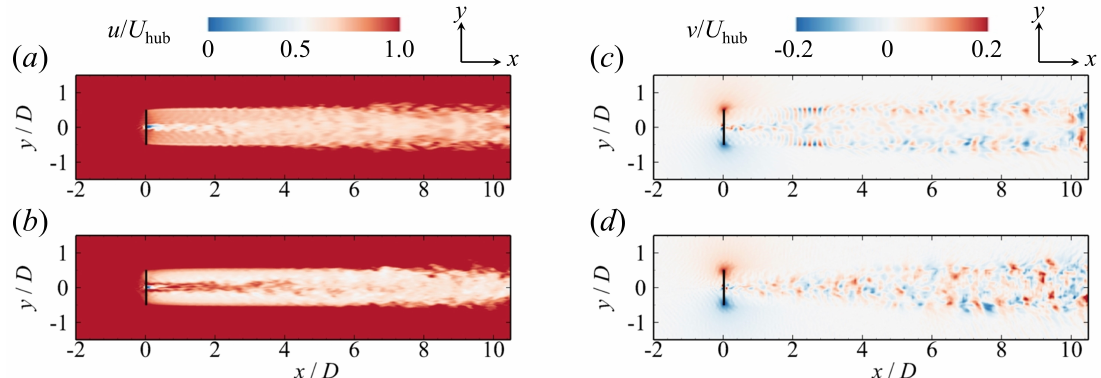
Figure 2. Uniform inflow: contours of the instantaneous velocity field behind the wind turbine on the horizontal plane at hub height. ( a ) streamwise velocity using AD; ( b ) streamwise velocity using AS; ( c ) spanwise velocity using AD; ( d ) spanwise velocity using AS. The solid black line at x = 0 illustrates the location and the diameter of the wind